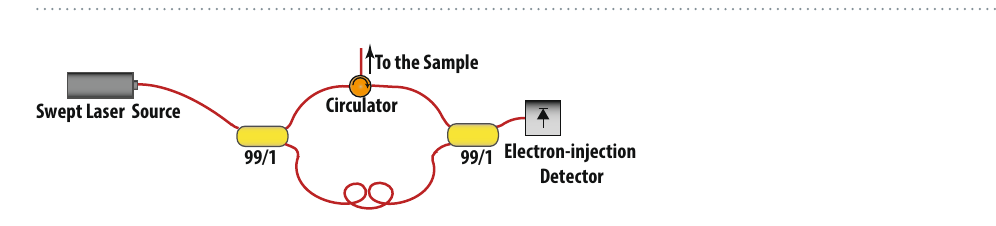
Figure 4. Measured A-line profile at a reference arm power of 350 nW at the electron-injection detector. The sample arm power at the electron-injection detector was 160 pW. The theoretical shot noise power at the electron-injection detector due to the statistical nature of incoming photons is marked via the red dotted line. The experimentally measured shot noise power lies at this ideal value.